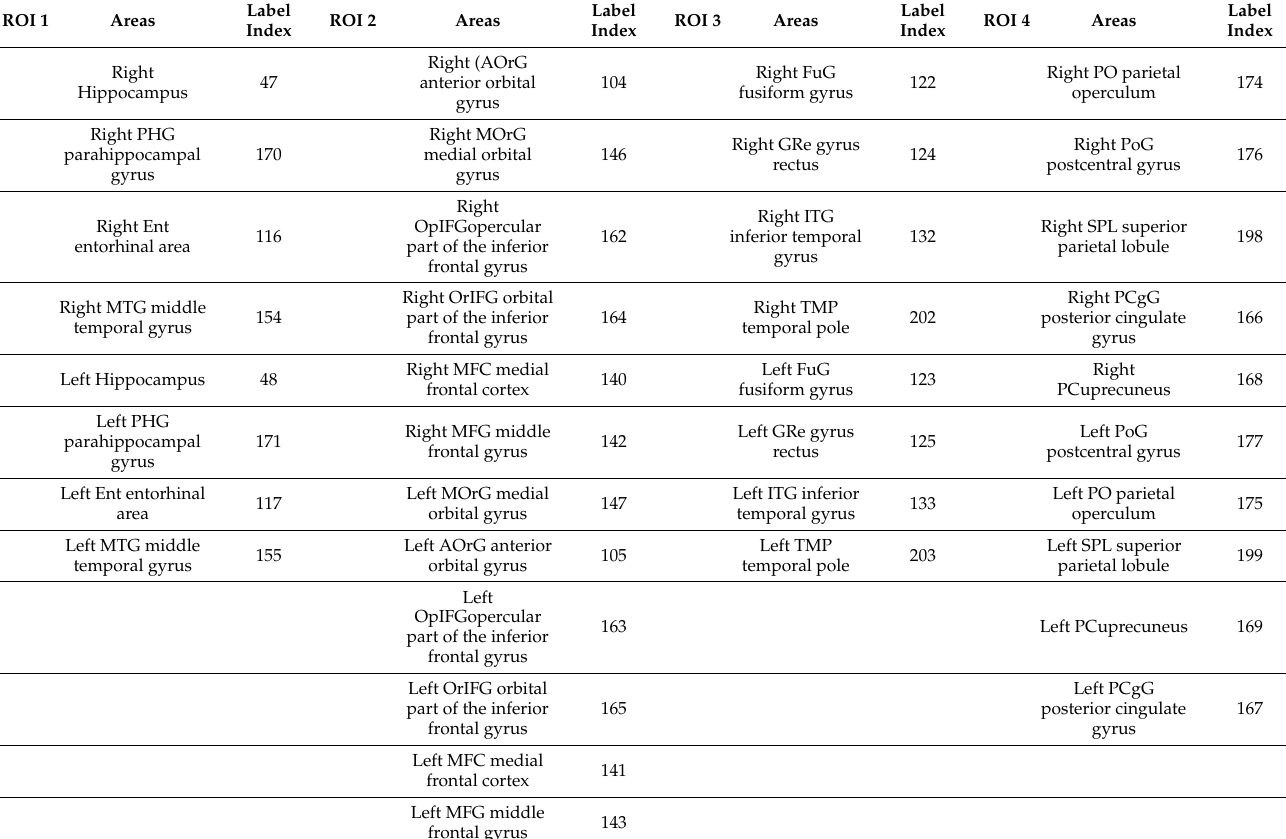
Table 1. Regions of interest (ROI) extracted from the cerebral segmentation using